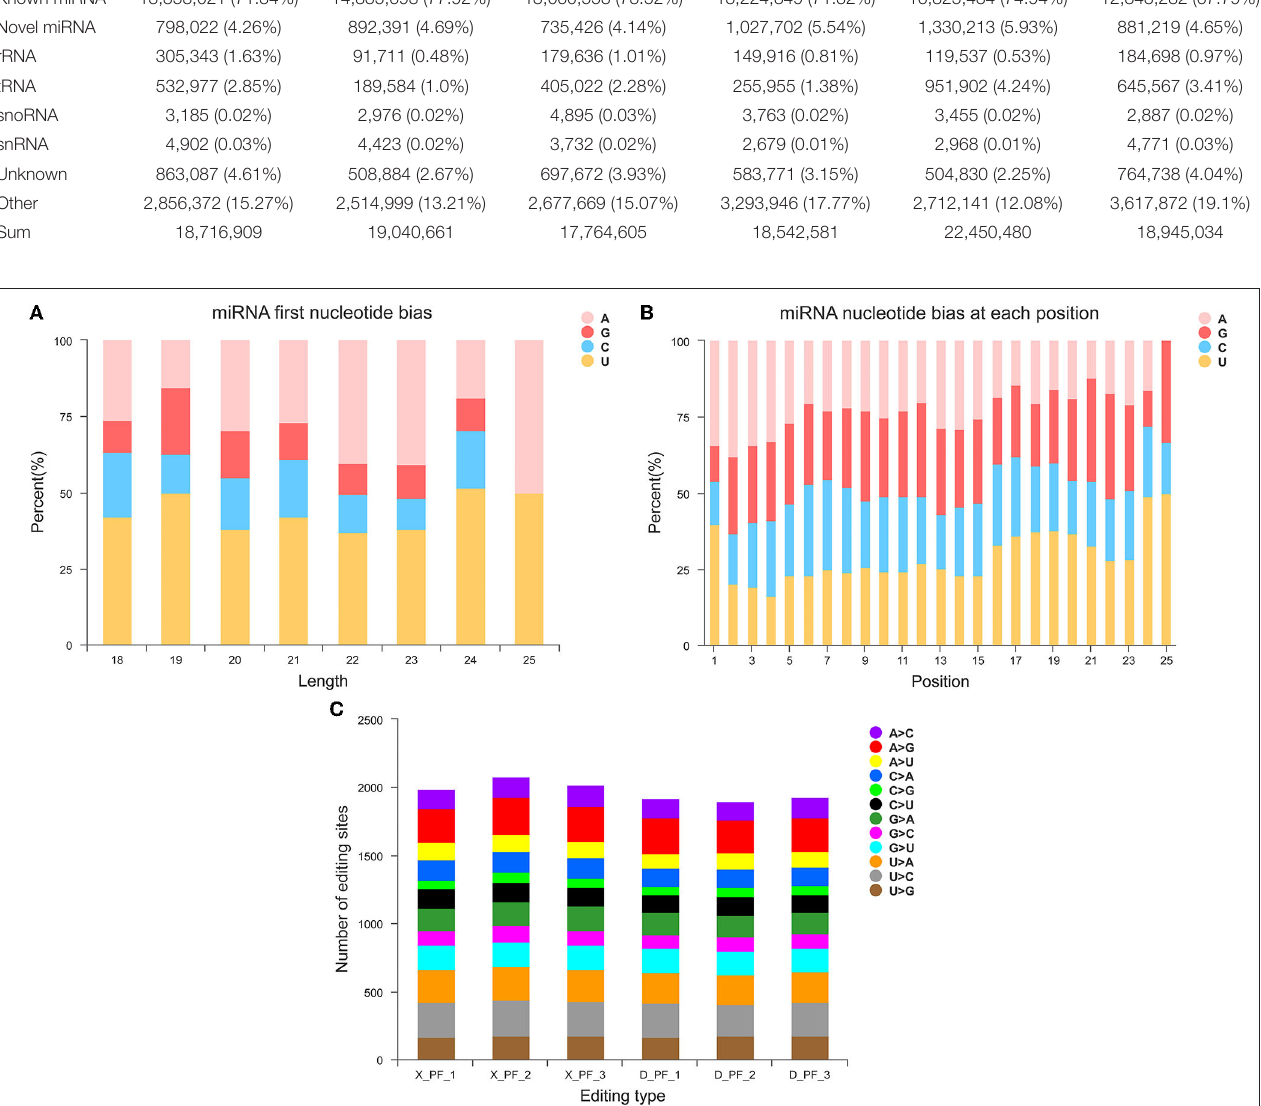
FIGURE 2 | Structural characteristics of miRNA. (A) First base preference distribution map of miRNAs with different lengths. (B) Distribution map of base preference at different miRNA sites. (C) miRNA base editing type distribution